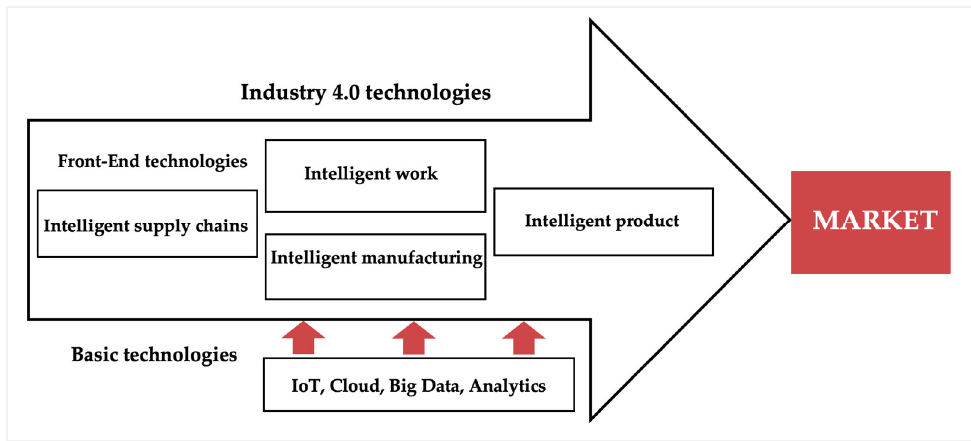
Figure 1. Schema for technologies in Industry 4.0. Source: Authors’ compilation.